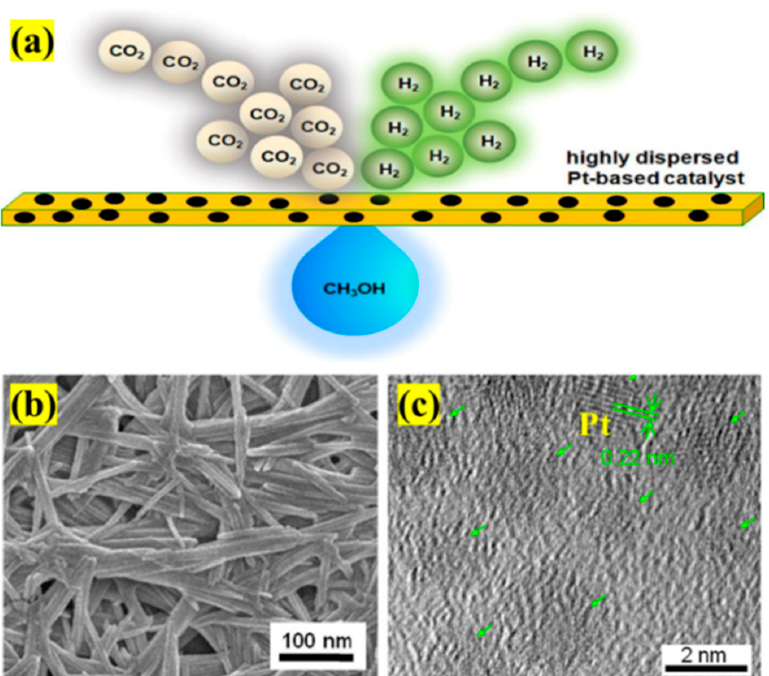
Figure 7. ( a ) The structure model of Pt/ fi lm/In 2 O 3 . ( b ) SEM image of Pt/ fi lm/In 2 O 3 . ( c ) HRTEM image of Pt/ fi lm/In 2 O 3 . Reproduced with permission from ref. [93]. Copyright 2019 Elsevier.